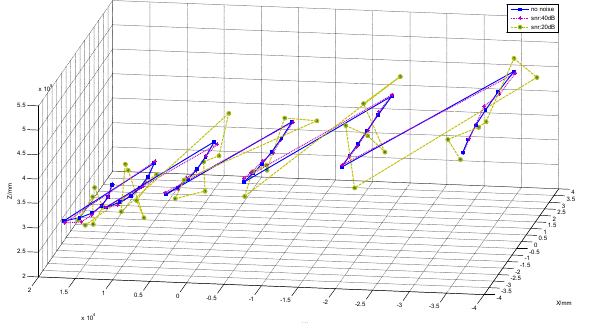
Figure 1. The measurements of noisy ground points X . If it is attempted to locate the corner of one image, whose accurate position is (-36.72,-36.72, 480) (meter). Then, the deduced positions from four models are listed in Table 1. ( Y , Z ) represents the estimated position, ( l l reflects the absolute deviation from the true value.  are the square roots of three diagonals of  l Z the metric of uncertainty. From Table 1, the location precision of SNR 40dB is usually higher than that of SNR 20dB, which explains the impact of measurement errors on the location precision. The fourth model, (homography model) can give a similar result as that of the second model (simplified model without radial distortion).